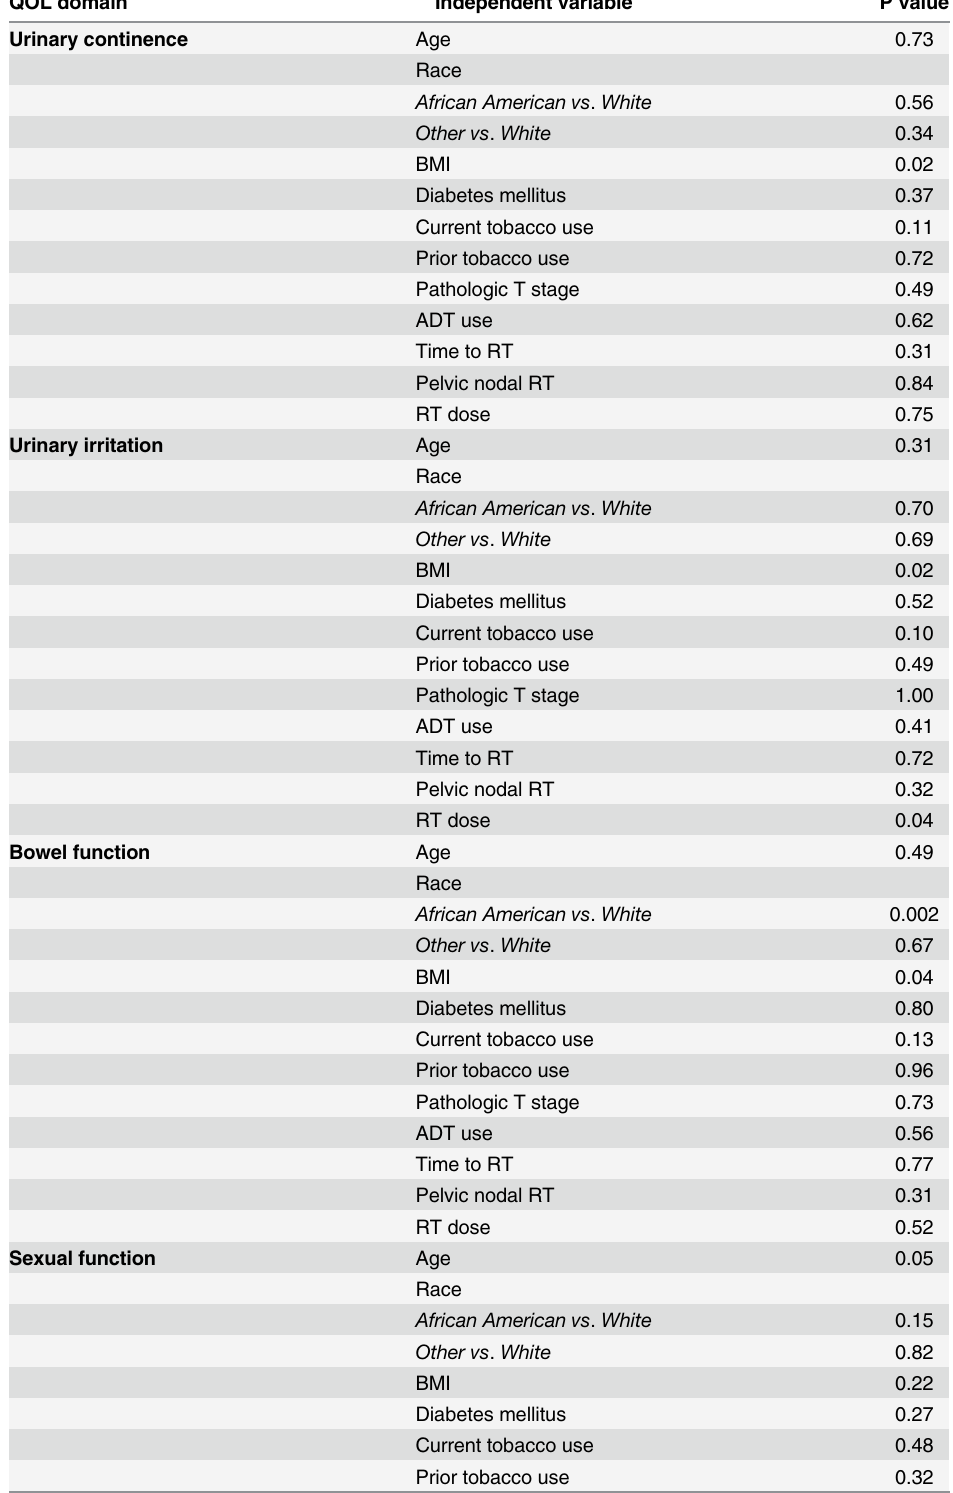
Table 3. Factors associated with each QOL domain on multivariate